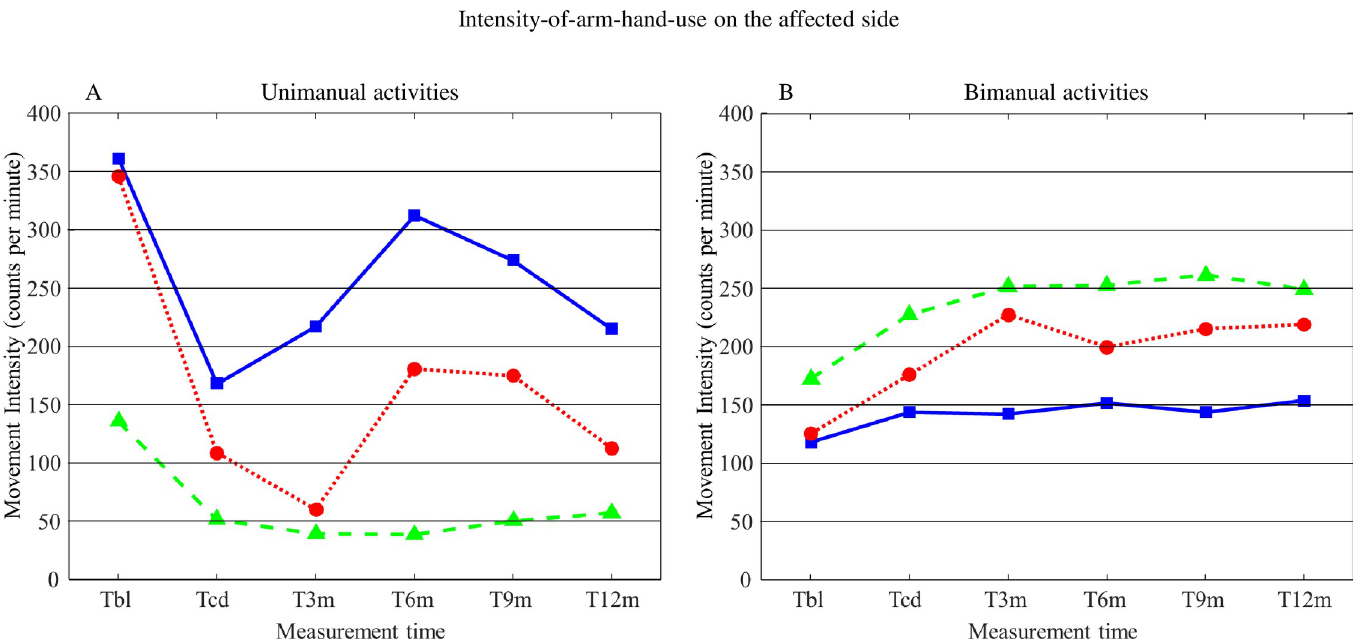
Fig 4. A: Mean values for Intensity-of-arm-hand-use on the affected side during unimanual activities for subgroups 1, 2 and 3. B: Mean values for Intensity-of-arm- hand-use on the affected side during bimanual activities for subgroups 1, 2 and 3. T = time; bl = baseline; cd = clinical discharge; m = month. Solid line = subgroup 1; Dotted line = subgroup 2; Dashed line = subgroup 3.